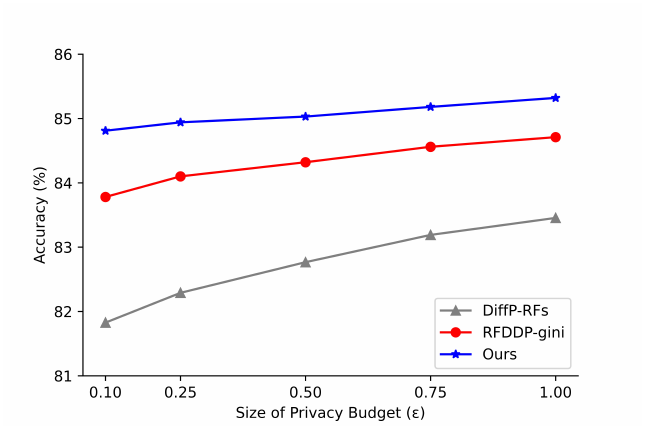
Figure 6. Comparison of classification performance of the three algorithms on Adult dataset.